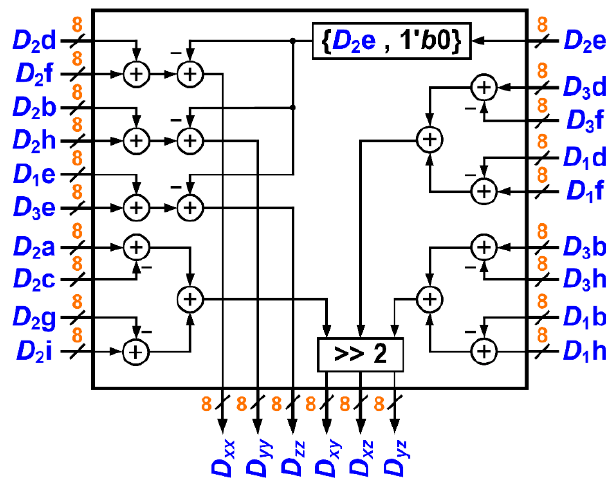
Figure 12. Hardware structure of the elements in 2D and 3D Hessian matrices.